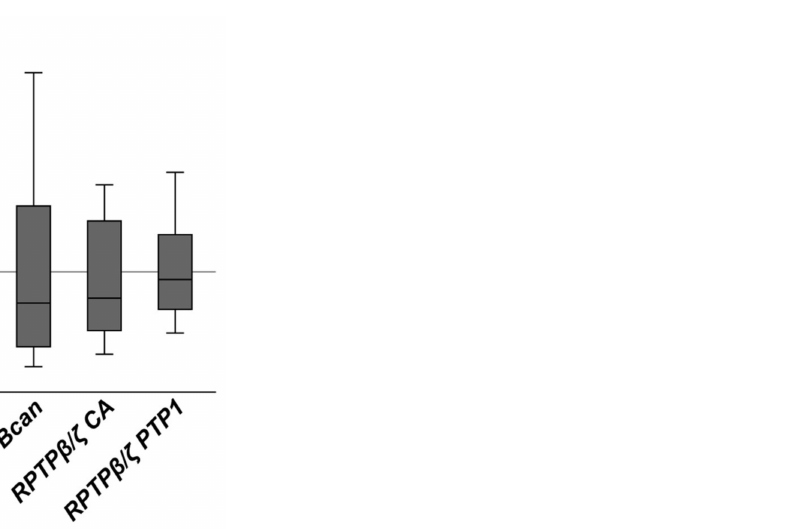
Figure 9. Expression of Acan , Bcan, and RPTP β / ζ splice variants was comparable in WT and glau- comatous HET optic nerves. On mRNA level, no differences were observed for Acan , Bcan, and the RPTP β / ζ splice variants detected by the primers RPTP β / ζ CA (all isoforms) and RPTP β / ζ PTP1 (receptor isoforms RPTP β / ζ long and RPTP β / ζ short ). Groups were compared using a pairwise fixed reallocation and randomization test. Data are shown as median ± quartile ± minimum/maximum. n = 5/group.